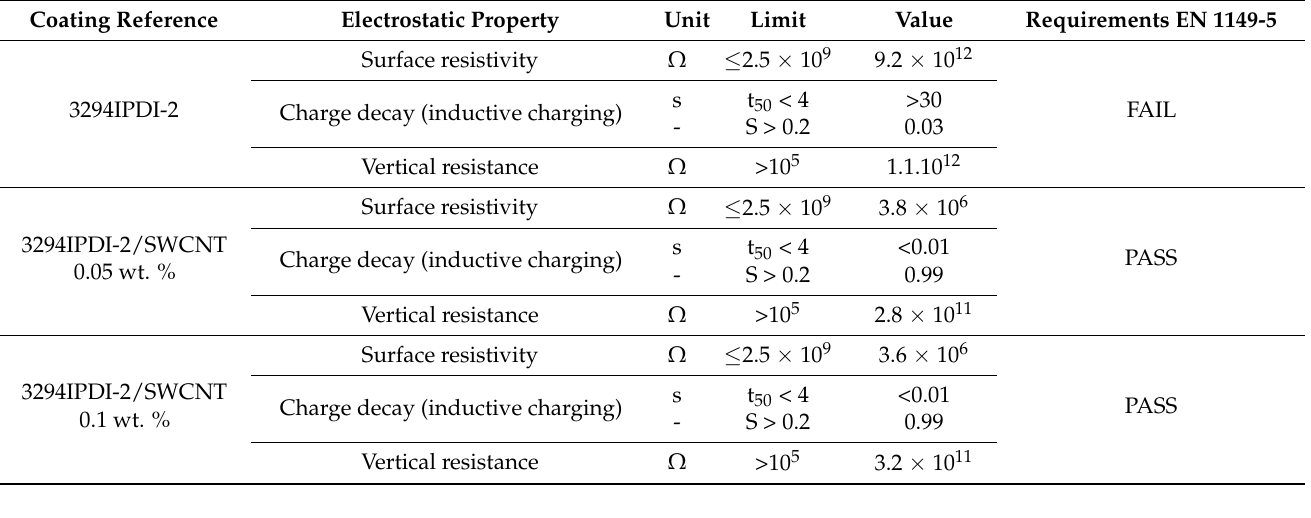
Table 10. Summary of electrostatic properties of UPRON fabrics coated with 3294IPDI-2 and 3294IPDI-2 doped with 0.05 and 0.1 wt. % SWCNT.